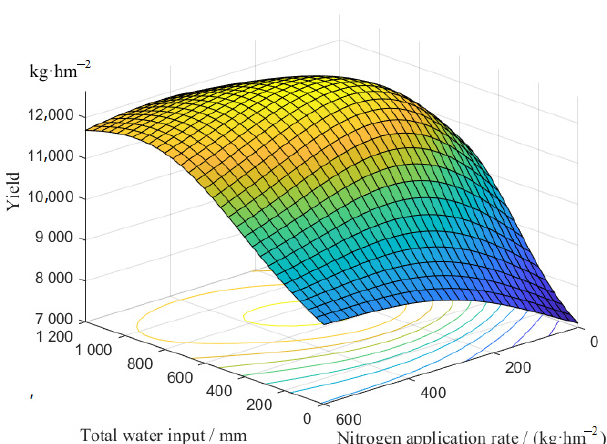
Figure 9. Yield prediction results with Gauss regression model for water and nitrogen coupling.